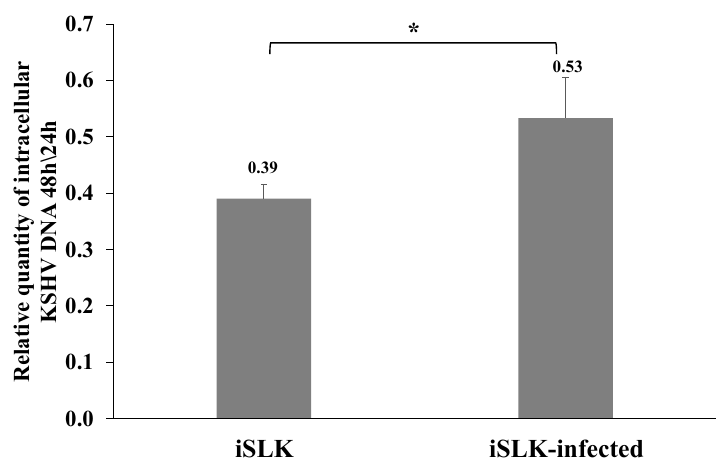
Figure 8. Relationship between the levels of incoming viral DNA in primary and superinfected cells 24 versus 48 h after infection. Uninfected and latently infected iSLK cells were infected with recombinant BAC16-mCherry or BAC16-mNeonGreen viruses at an MOI of 0.5 and processed as described in Figure 7 at 24 and 48 h post infection. Ratios of viral DNA levels obtained 48 and 24 h after infection are presented showing decreasing quantities of incoming viral DNA between 24 and 48 h post infection. Results obtained are from three independent experiments. Statistical analysis was performed using the Welch Two Sample t -test. * p < 0.05.